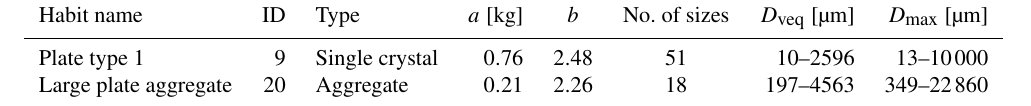
Table 1. Overview of the selected habits: a and b are the parameters of the mass–size relationship (Eq. 13), D veq is the volume-equivalent diameter, and D max is the maximum diameter. ID is the identification number from the database of Eriksson et al. (2018).